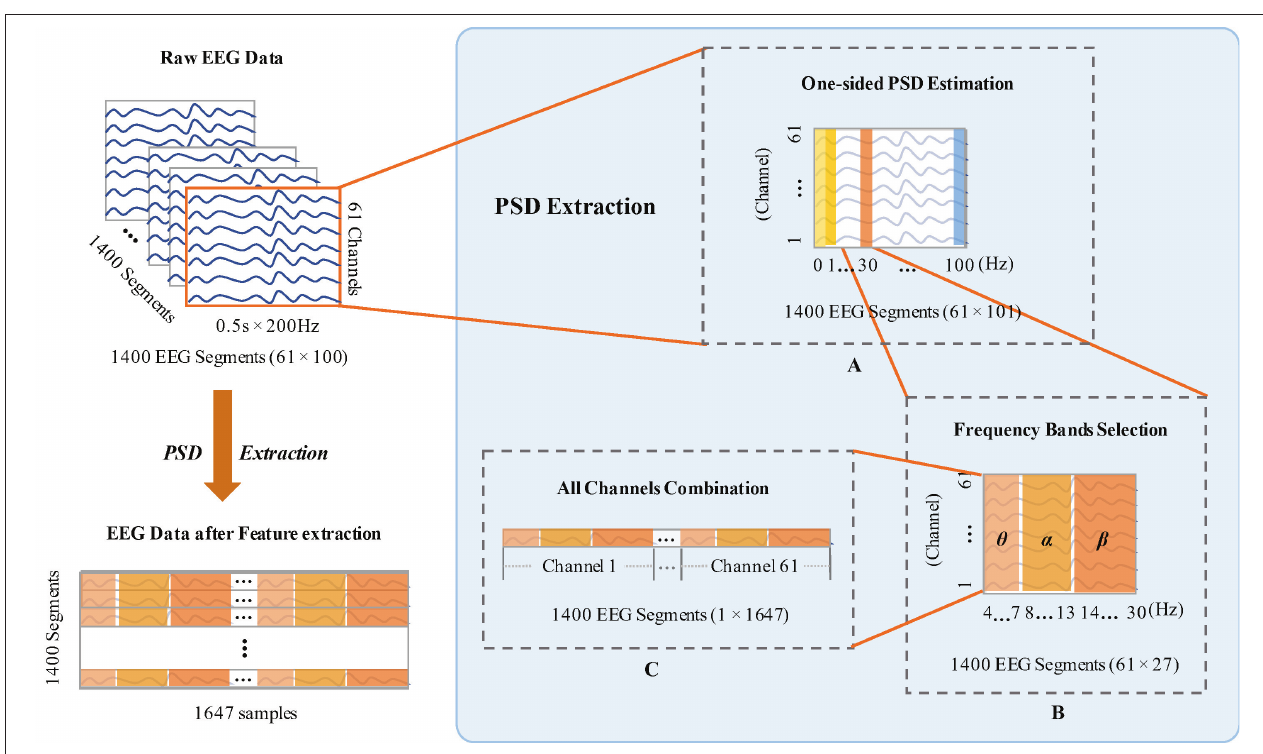
FIGURE 3 | The preprocessing of each subject EEG data by power spectral density (PSD). (A) Introduces the one-sided PSD estimation to determine the logarithm of the signal power between 1-100Hz. (B) Obtains the PSD features at three selected frequency bands. (C) Gets 1647 characterizes from all channels in each segment.